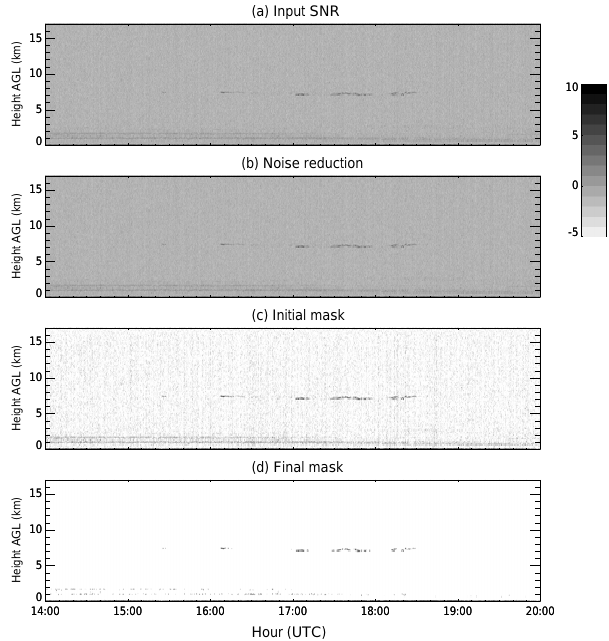
Figure 4. Illustration of the steps of the detection method using the real data from 8 January